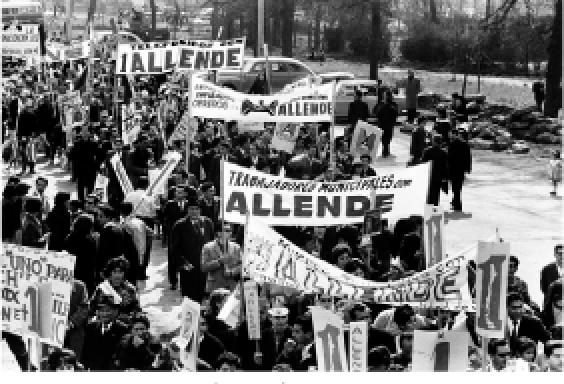
A march in support of Salvador Allende, who influenced the development of Latin American social medicine(Photo: US Library of Congress)